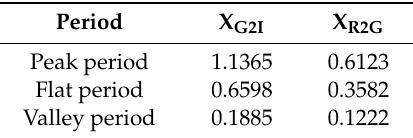
Table 2. Time-of-use price (¥ / kW · h).